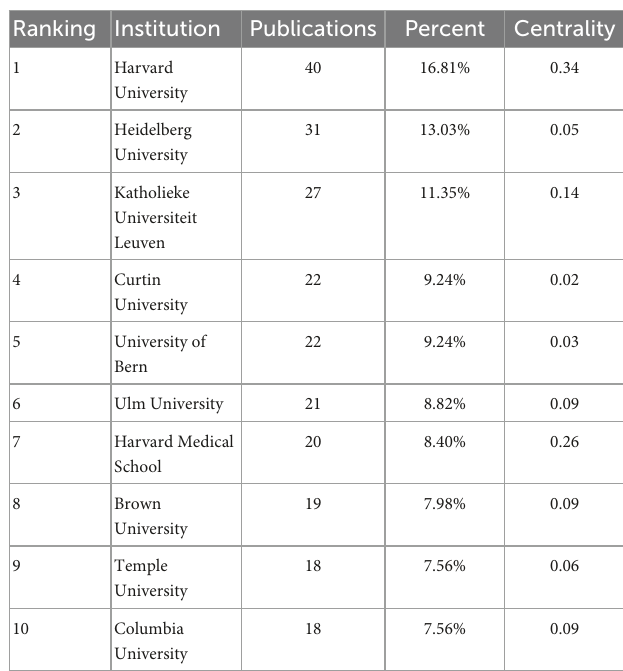
TABLE 1 The top 10 institutions related to non-suicidal self-injury (NSSI).